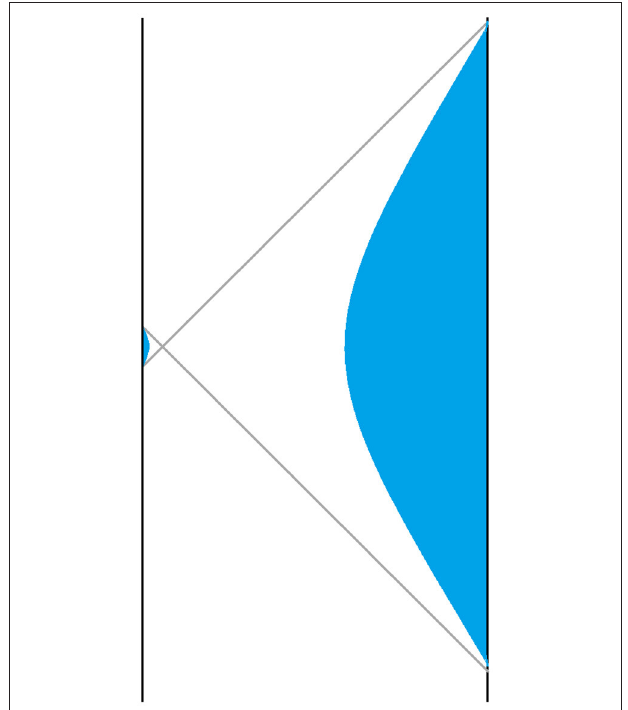
FIGURE 10 | Fixing a